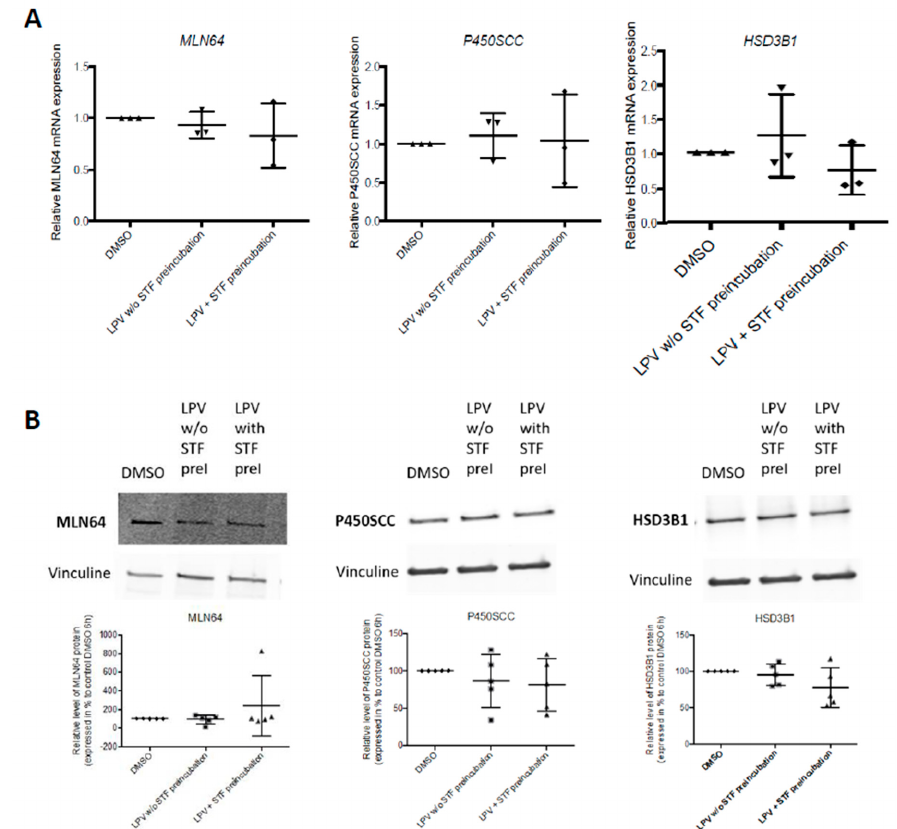
Figure 15. Inhibition of IRE1 α pathway does not prevent the inhibitory effect of LPV on P4 synthesis partners expression. VCT cells isolated from human term placenta were cultured for 72 h. Cells were further incubated for 2 h with STF (100 µM) (LPV + STF preincubation) or DMSO control (LPV without ( w/o ) STF preincubation) before incubation for 4 h with LPV (10 µM). MLN64, P450SCC and HSD3B1 expression was evaluated by RT-qPCR ( A ) and Western blot using anti-MLN64, anti-P450SCC and anti-HSD3B1 antibodies ( B ). Vinculin protein expression determined by Western blot using anti-vinculin antibody was used as loading control. The results are presented as the mean +/ − SD from n = 3 independent experiments for RT-qPCR and n = 5 independent experiments for Western